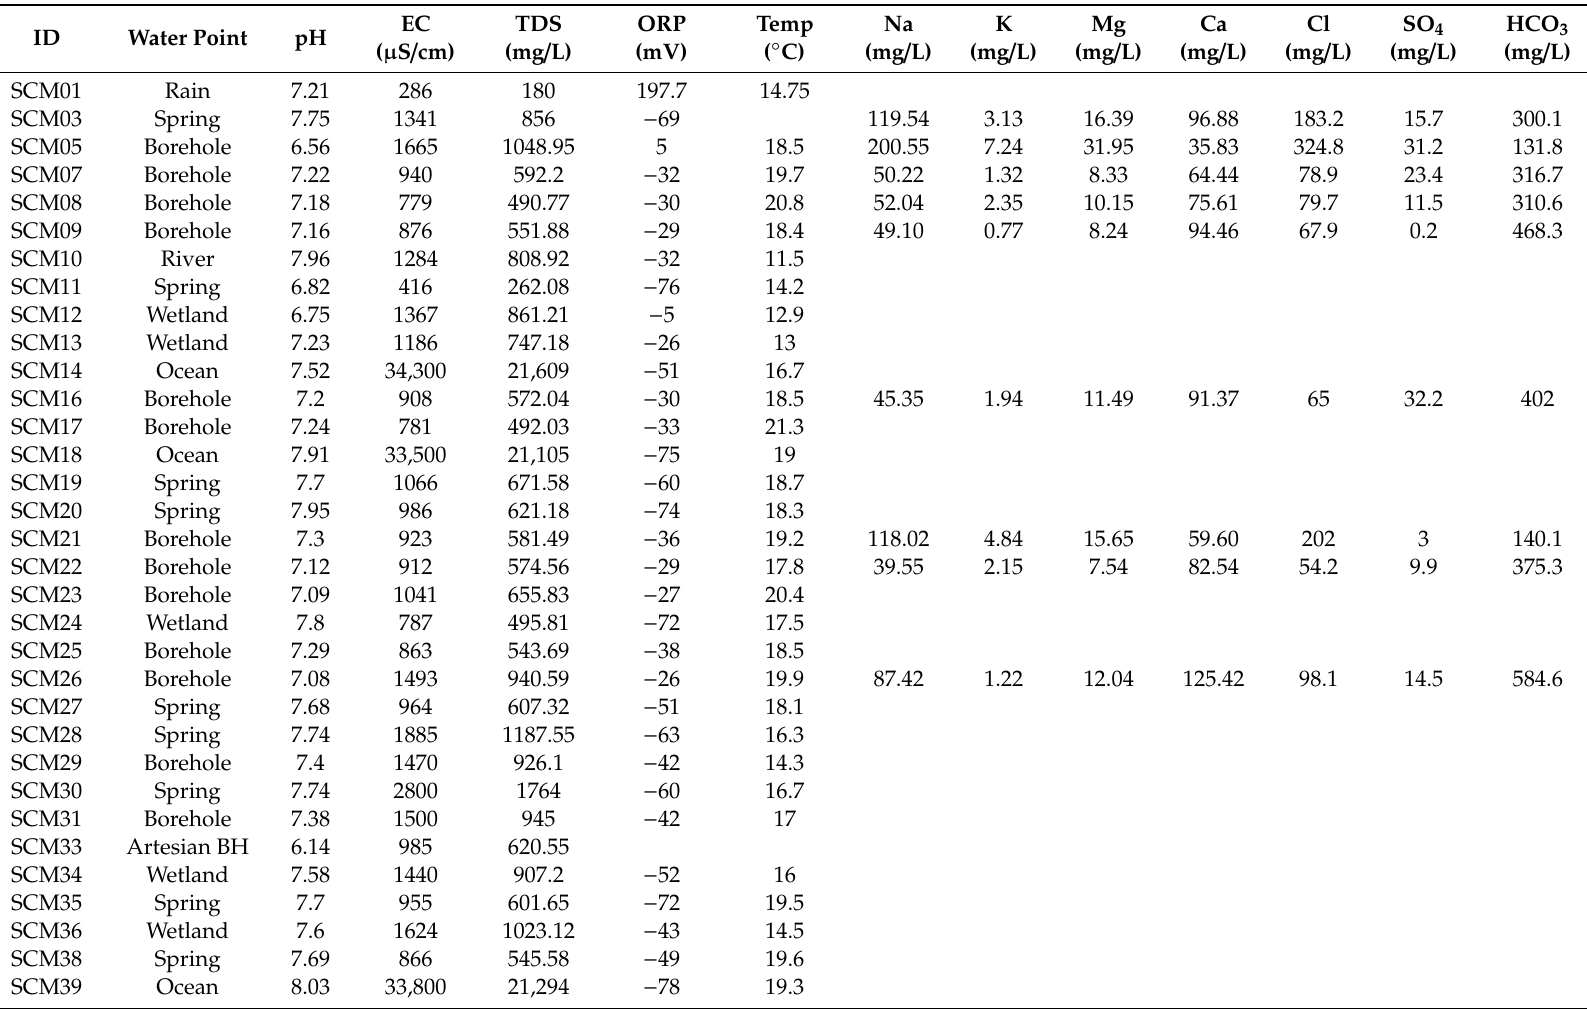
Table 3. Physicochemical, chemical and descriptive statistics for water samples in the Thyspunt